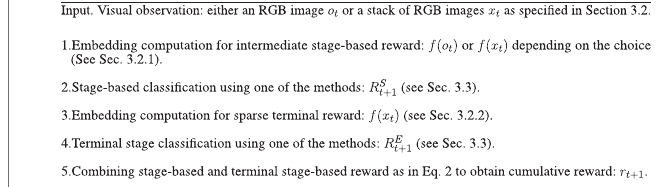
Algorithm 1. Visual rewards for sequential tasks: work fl ow of experiments at test time.